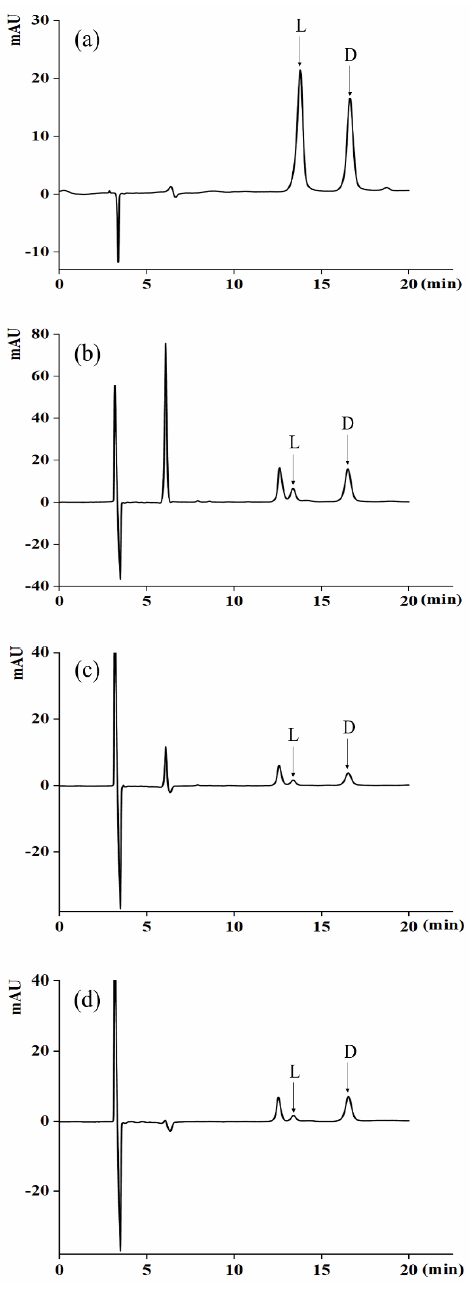
Figure 2. Separation of lactic acid isomers in Baijiu samples. ( a ): lactic acid standard, ( b ): MT43 Baijiu sample spectrum, ( c ): WLY Baijiu sample spectrum. ( d ): LBFJ Baijiu sample spectrum. Table 1. Correlation coefficients, LODs, linear ranges, recovery rates, RSDs.